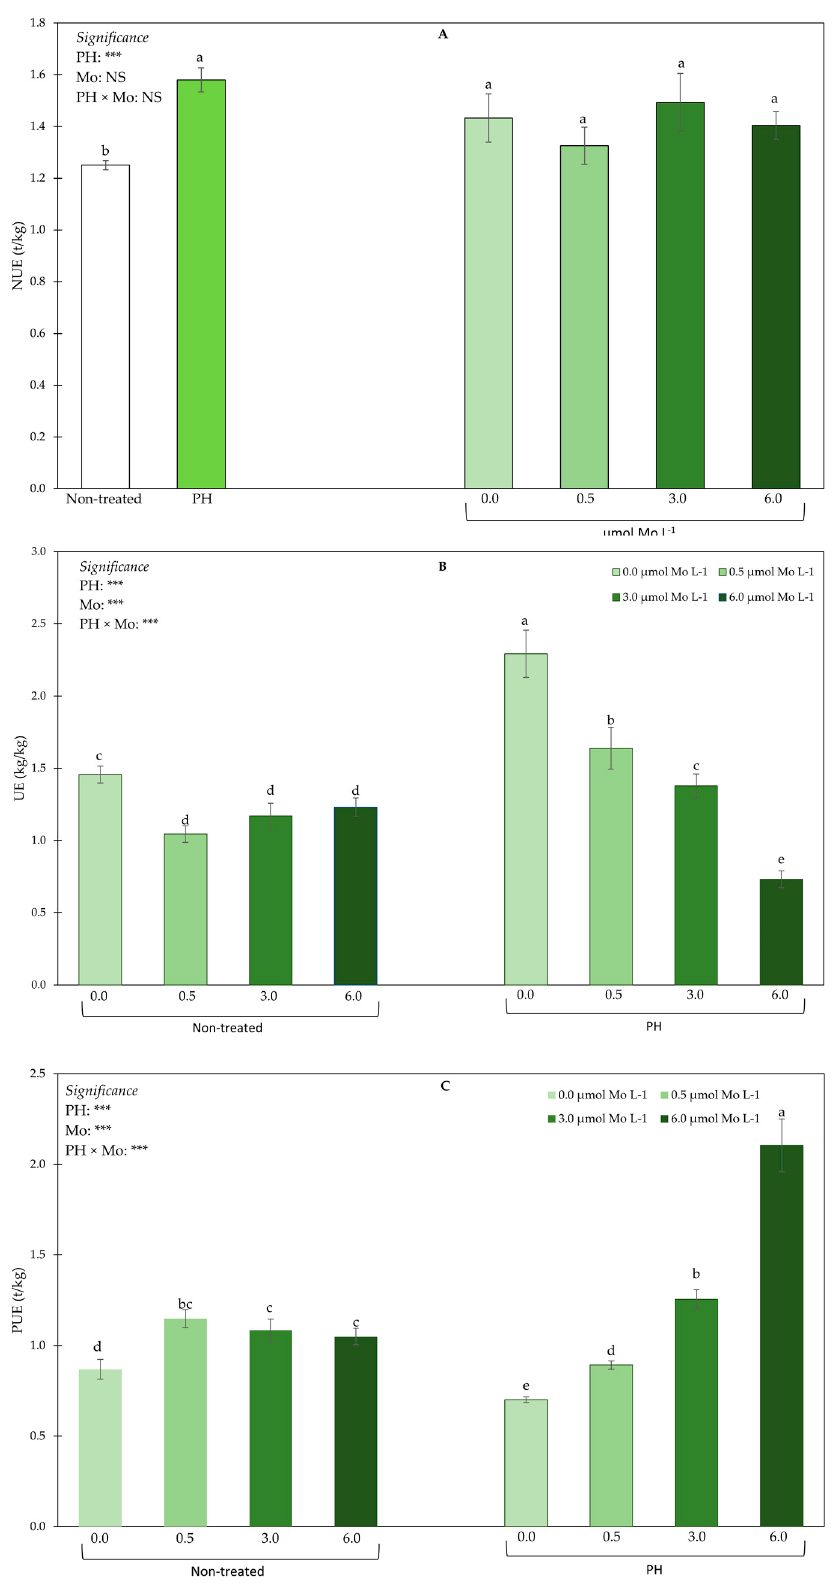
Figure 5. Effects of PHs and Mo treatments on nitrogen use efficiency ( A ), nitrogen utilization efficiency ( B ) and nitrogen physiological use efficiency ( C ) of ‘Canasta’ lettuce plants. Values with distinct letters significantly differ at p ≤ 0.05. NS, *** non-significant or significant at or 0.001,